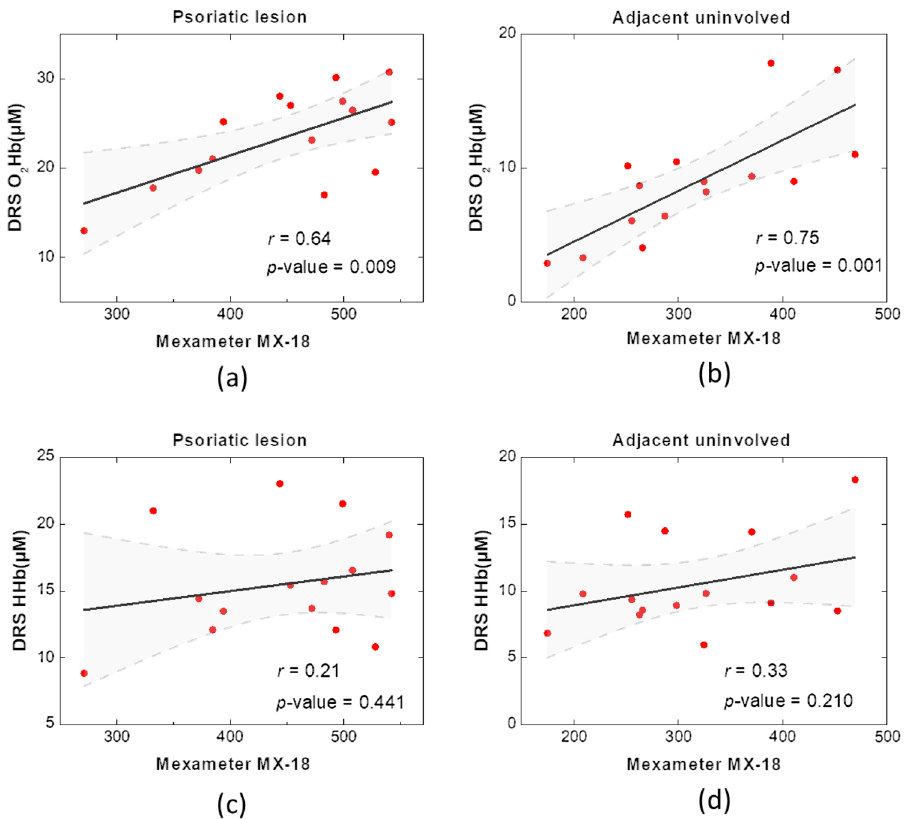
Figure 4. Correlation plots for the oxygenated and deoxygenated hemoglobin values and erythema scores obtained from DRS and Mexameter, respectively, at ( a , c ) psoriatic lesion, and at ( b , d ) adjacent uninvolved skin. Shaded domain represents 95% confidence band. A p -value greater than 0.05 represents that the fitted model is not significantly different from the model y = constant (no